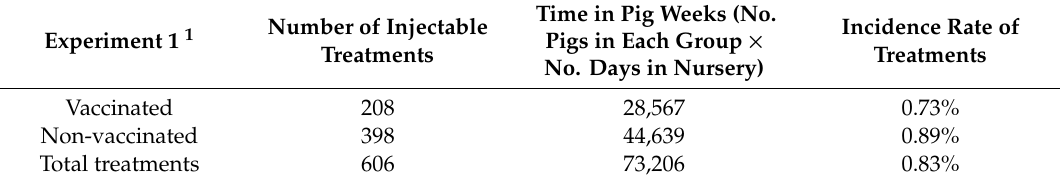
Table 2. Distribution of treatment data among vaccinated and non-vaccinated piglets in the post- weaning period.